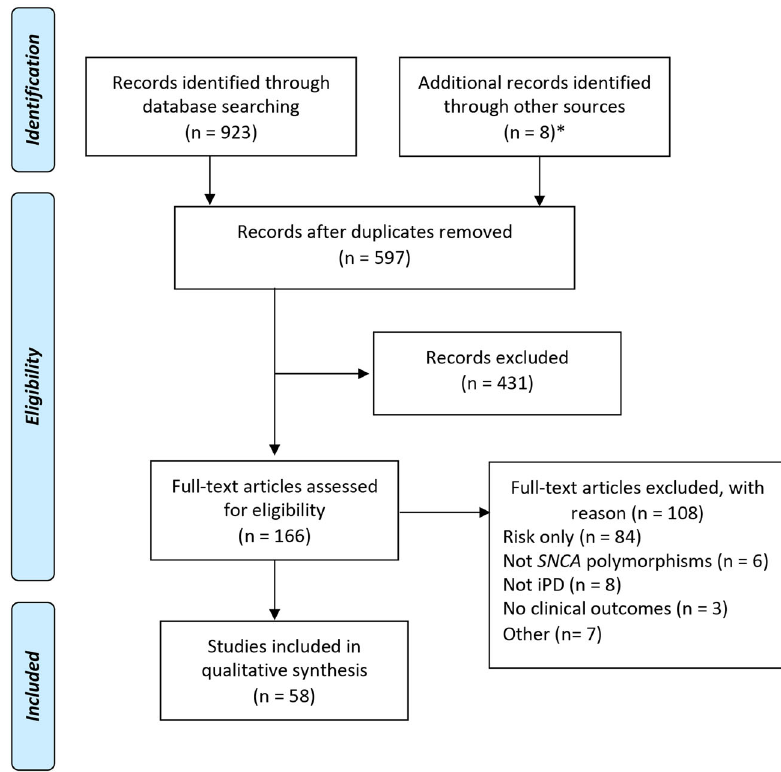
Fig. 1 Study selection fl ow diagram. Asterisk (*): eight further articles were retrieved from a manual search of the 50 evaluated papers ’ references ( n = 5) and from the wider PD literature ( n = 3). iPD idiopathic Parkinson ’ s disease, SNP single-nucleotide